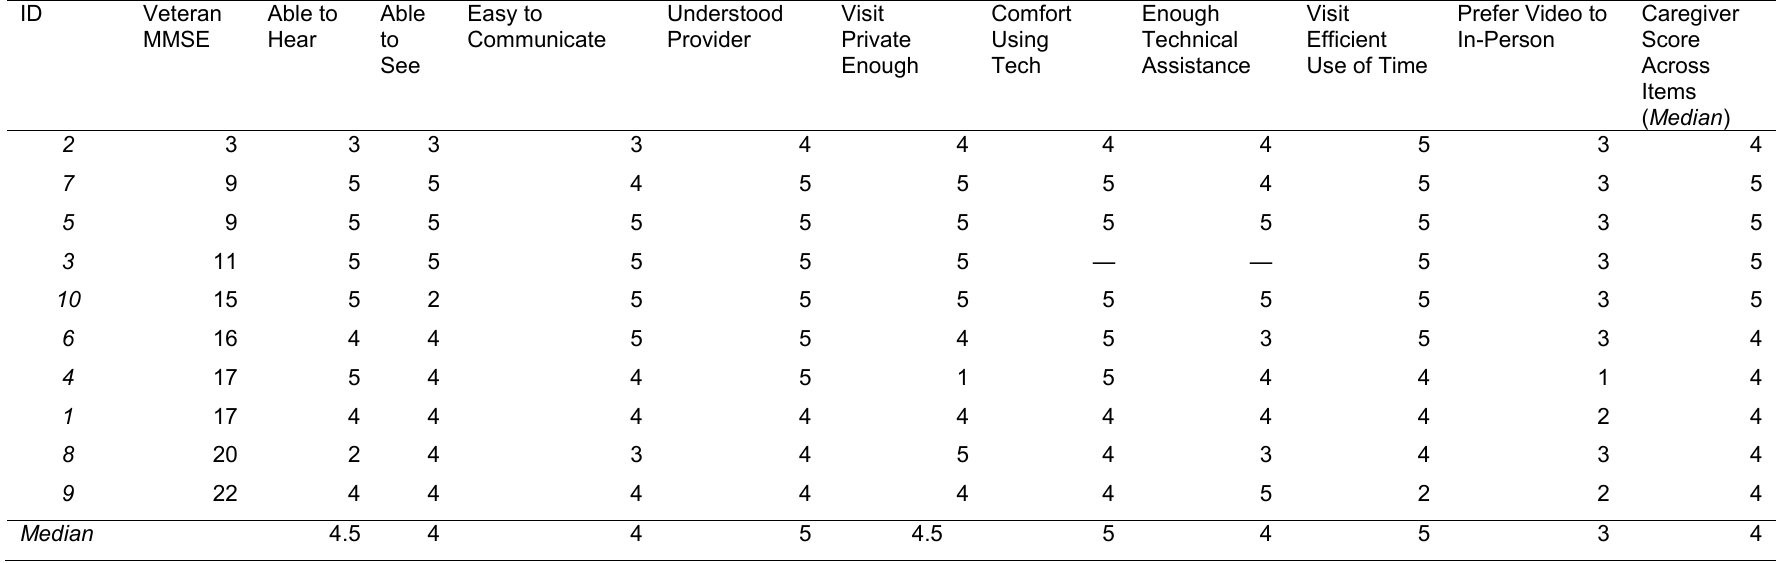
Caregiver Satisfaction with Video Telehealth Home Safety